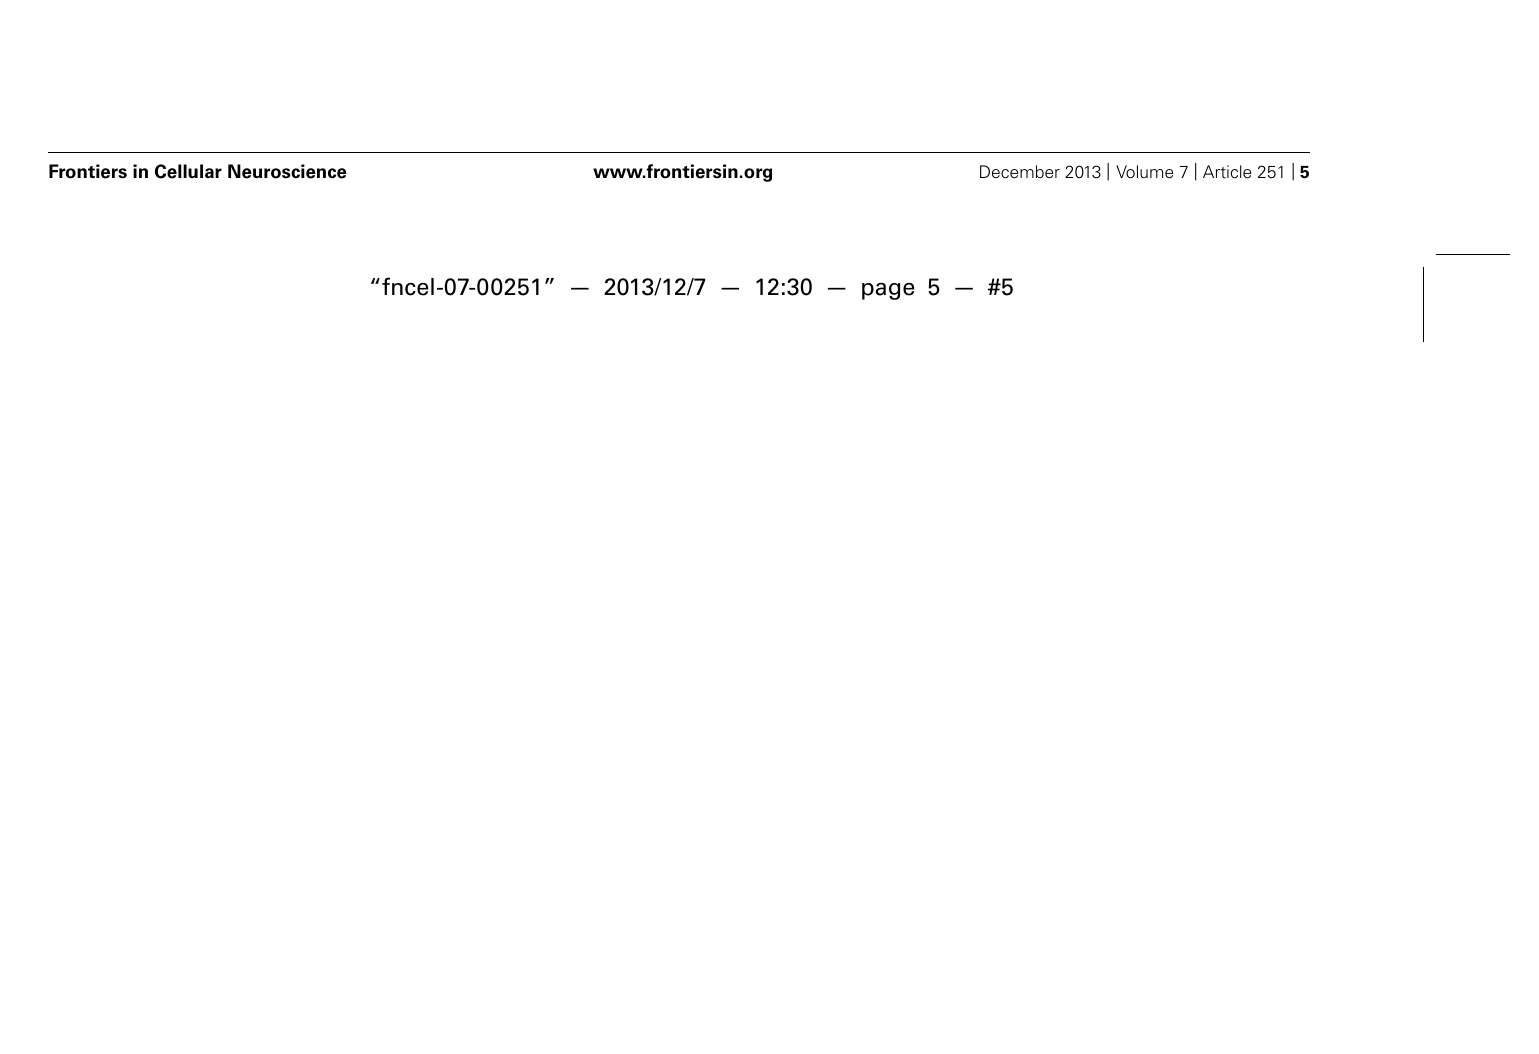
FIGURE 2 | PKC activation modifies EAAT-1 sub-cellular distribution in primary astrocytes. (A) Fluorescence confocal microscopy showing the EAAT-1 immunoreactivity in vehicle-treated (left picture), PMA-treated (middle panel) and PKC inhibitor chelerythrine (CHE)/PMA-treated astrocytes (right picture). Scale bar: 10 μ m. (B) Surface biotinylation of astrocytes showing the increased signal for internalized EAAT-1 (S1, non-biotinylated) and reduced surface EAAT-1 (S2, biotinylated) after PMA. One lane represents a homogenate from 75 cm 2 confluent astrocytes. Quantifications were made from 5 blots corresponding to 5 independent flasks. ** p < 0.01, Student’s t -test. (C) Subcellular fractionation by ultracentrifugation on sucrose gradient followed by western-blot showing that PMA treatment produces a relative enrichment of EAAT-1 in